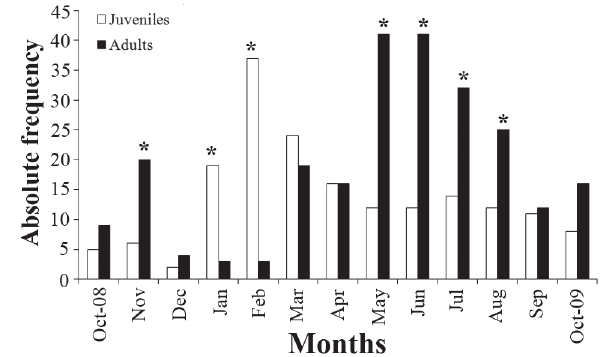
Fig. 10. Monthly absolute frequency distribution of juveniles and adult individuals of Etropus crossotus in the shallow infralittoral areas of the Paranaguá Estuarine Complex. Total amostral N = 419. *Significant values (p < 0.05) for chi-square test.